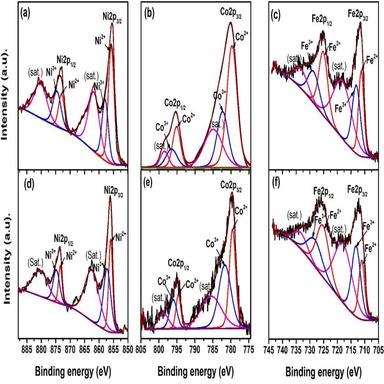
XPS spectra of Ni 2p (a), Co 2p (b), and Fe 2p (c) before; and Ni 2p (d), Co 2p (e), and Fe 2p (f) after 5 cycles of reaction using NiCoFe-LDO.